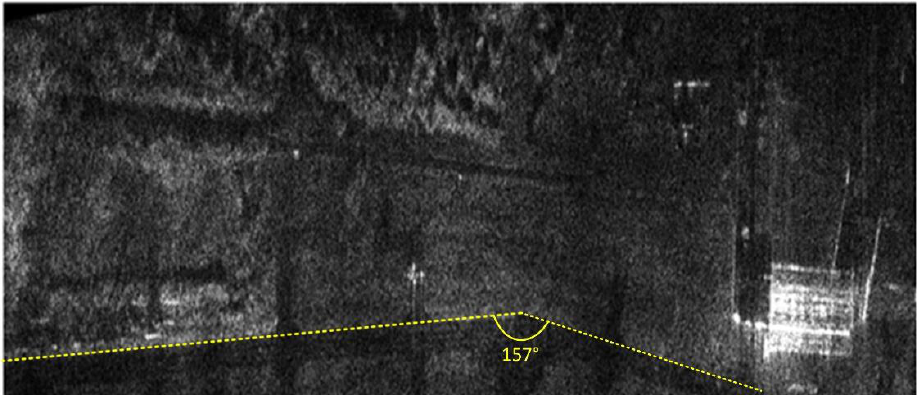
Figure 12. Radar terrain image obtained with the use of INS data; yellow line—the north edge of the taxiway determined using an INS-based image.